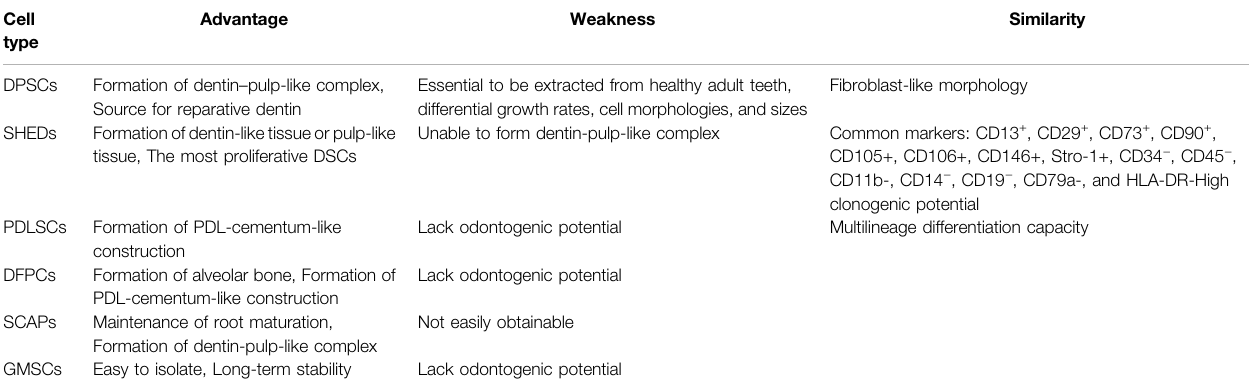
TABLE 1 | The common and different properties for each type of